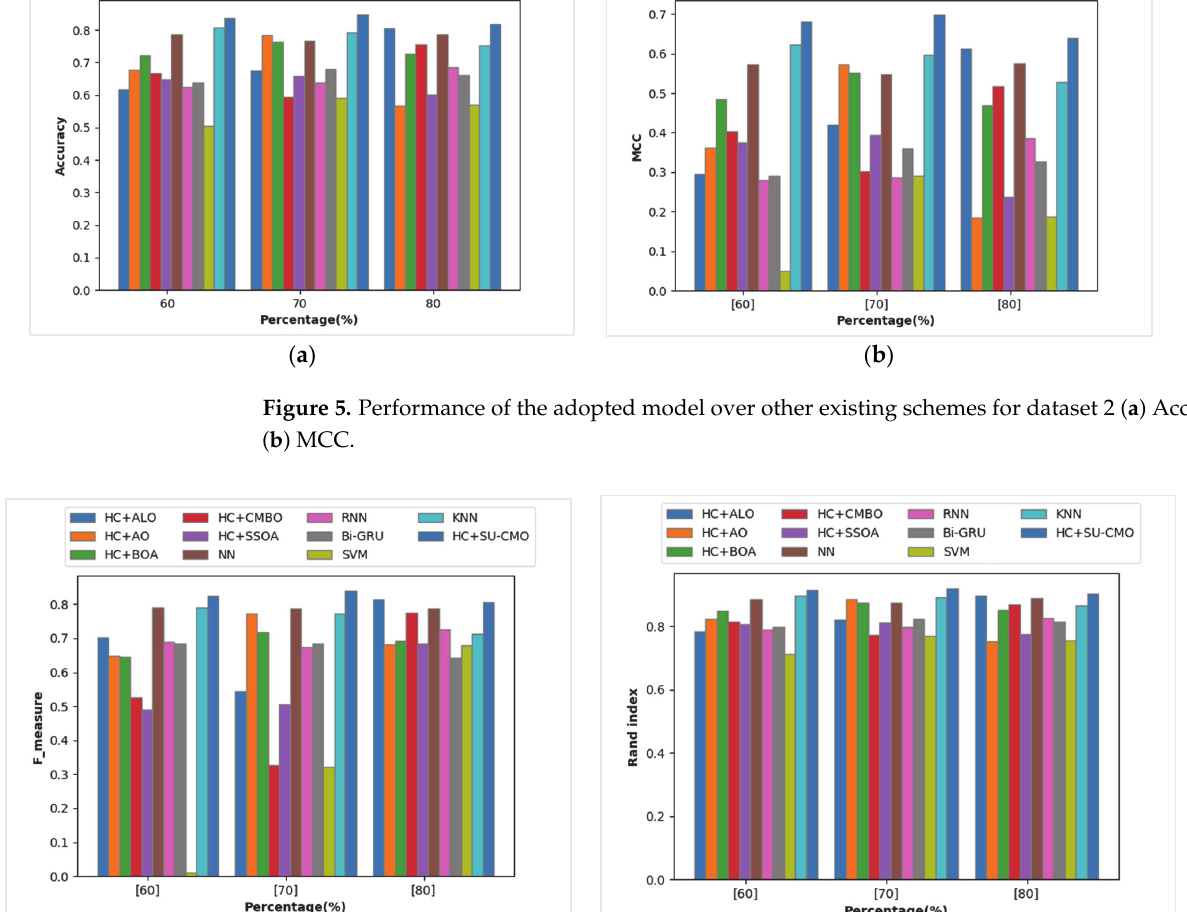
Figure 4. Performance of the adopted model over other existing schemes for dataset 1 ( a ) F-measure ( b ) Rand Index.